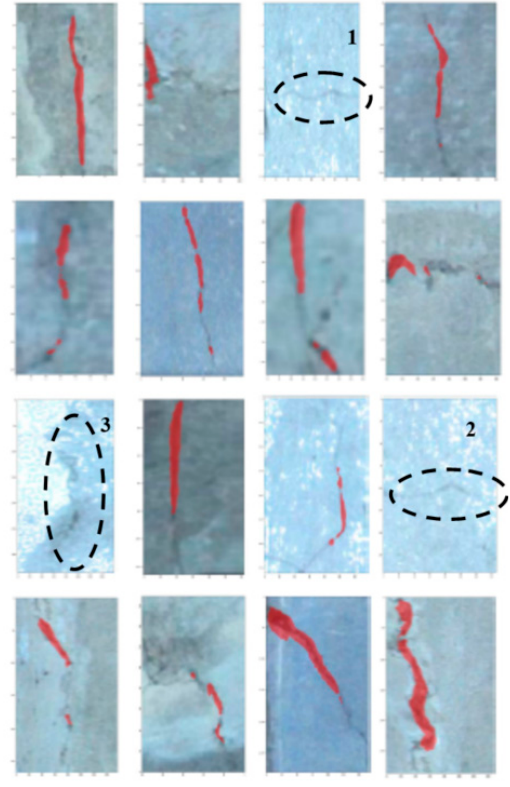
Figure 6. The training dataset of crack.